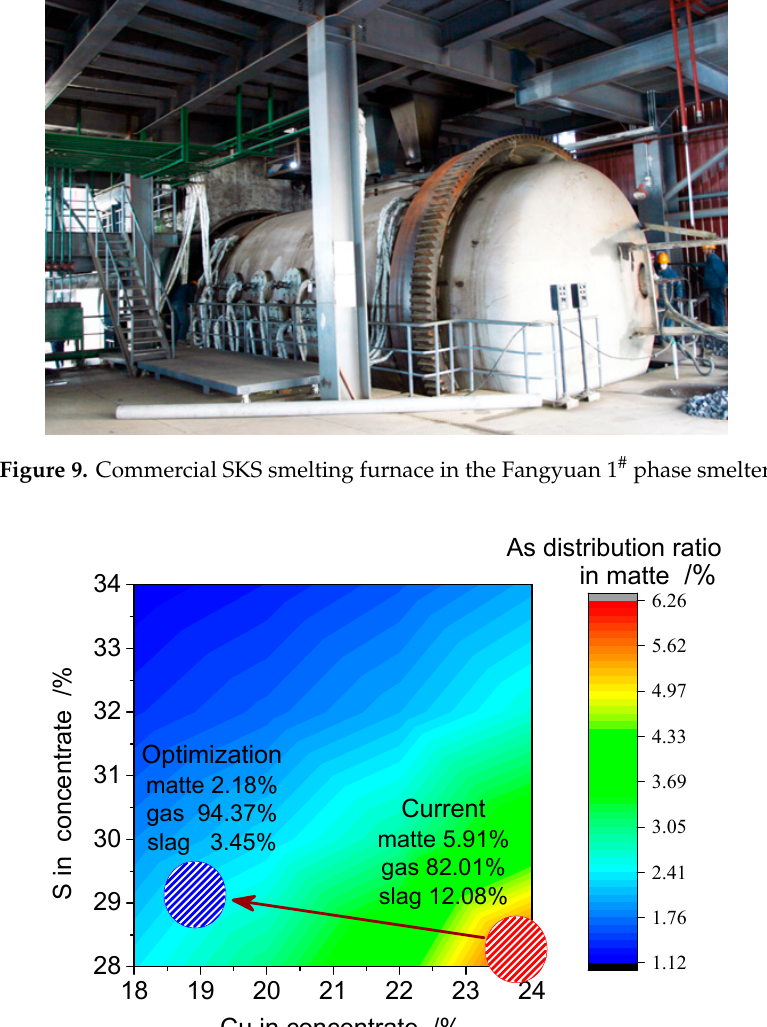
Figure 9. Commercial SKS smelting furnace in the Fangyuan 1 # phase smelter.